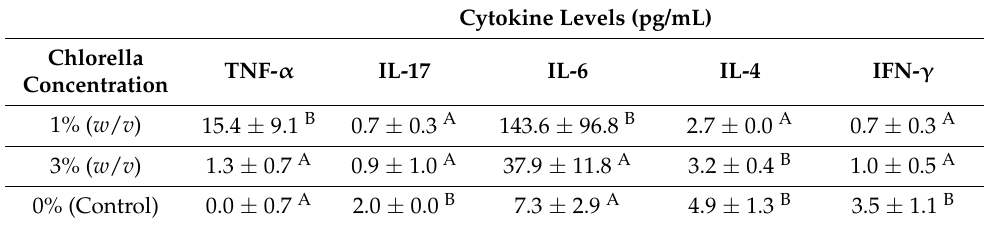
Table 2. Cytokine levels following Chlorella